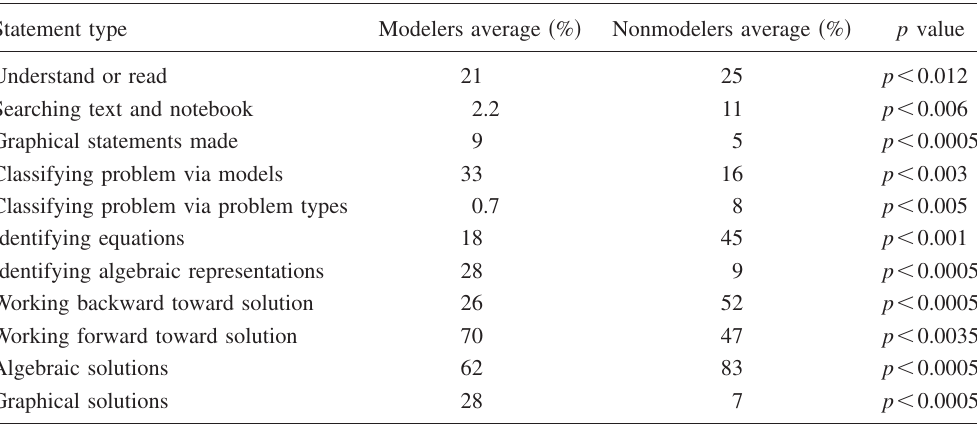
TABLE V. Summary of statistics for problem-solving